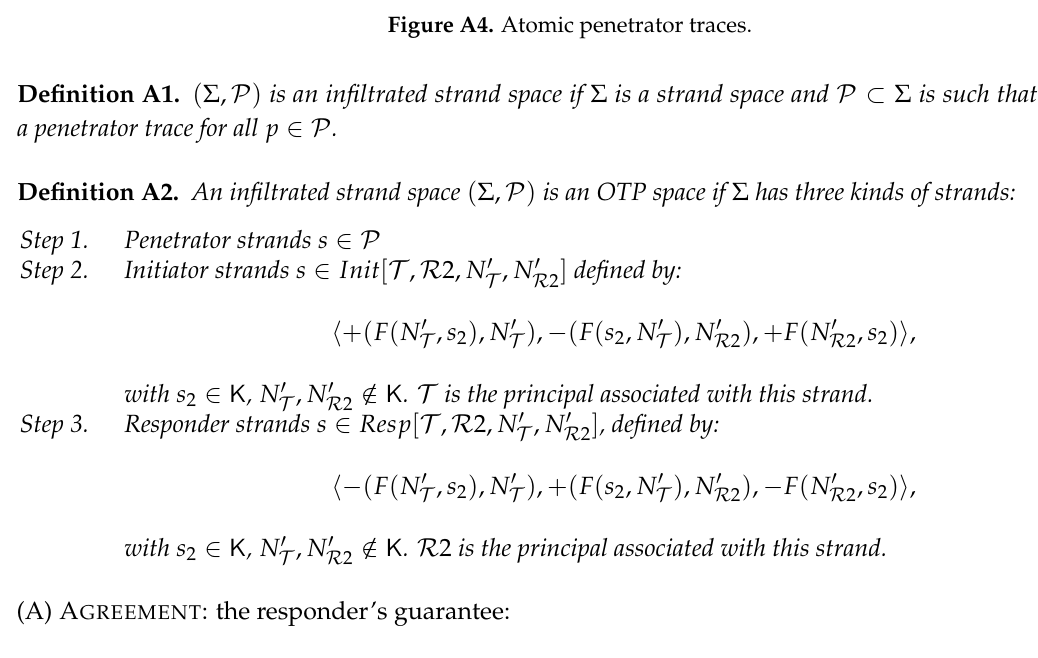
Figure A4. Atomic penetrator